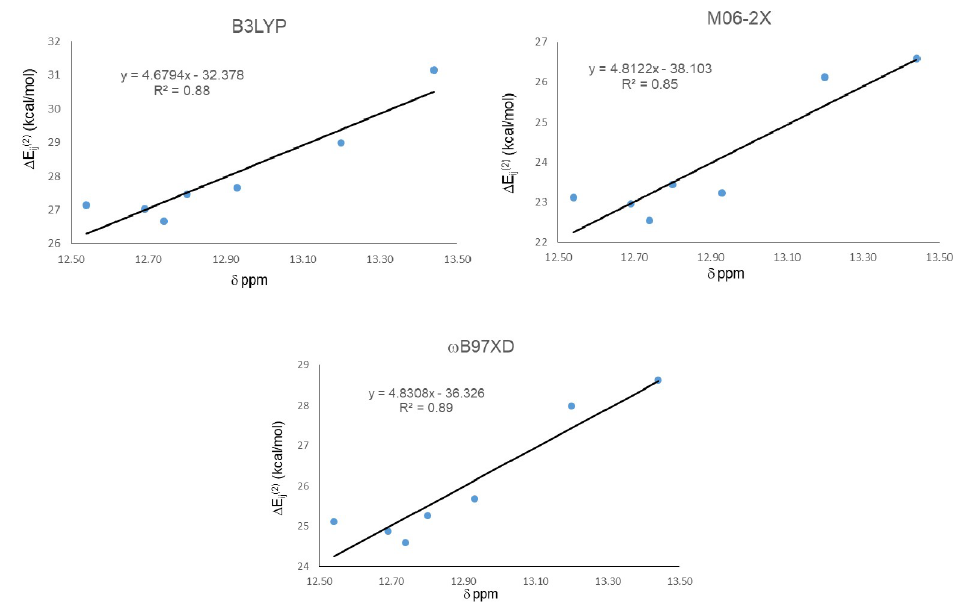
Figure 3. Correlations between second order stabilization energies ∆ E ij(2) LP O 15 → σ * O 11 -H 16 and 1 H-NMR chemical shifts ( δ ) for IMHB.